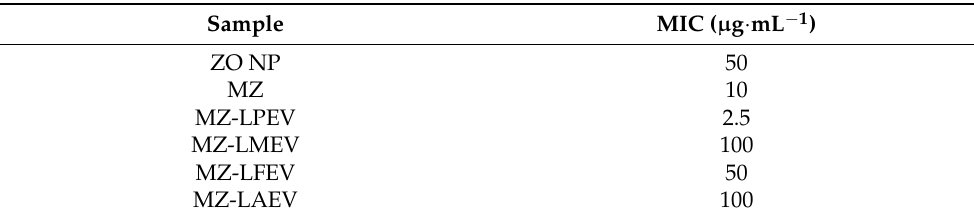
Table 2. MIC values of ZO NP, MZ, and Lactobacillus strain EV-coated MZ against S. aureus (ATCC 25923) 1